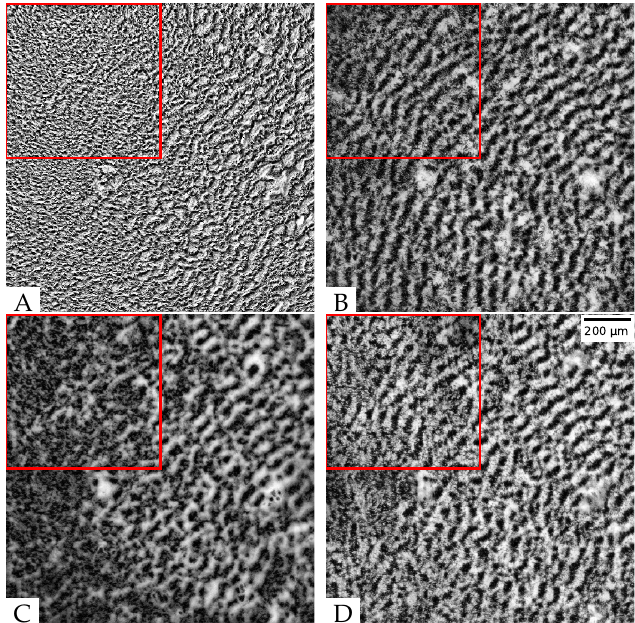
Figure 7. Rippling images and the detected wavelength λ k in the red box. The size of the red square box is 1 of the whole image. ( A ) Phase-contrast rippling image λ k ∼ 21 µ m; ( B ) tdTomato fluorescent 4 rippling image λ k = ∼ 46 µ m; ( C ) synthesized fluorescent rippling image before training λ k ∼ 63 µ m; ( D ) synthesized fluorescent rippling image after training λ k ∼ 46 µ